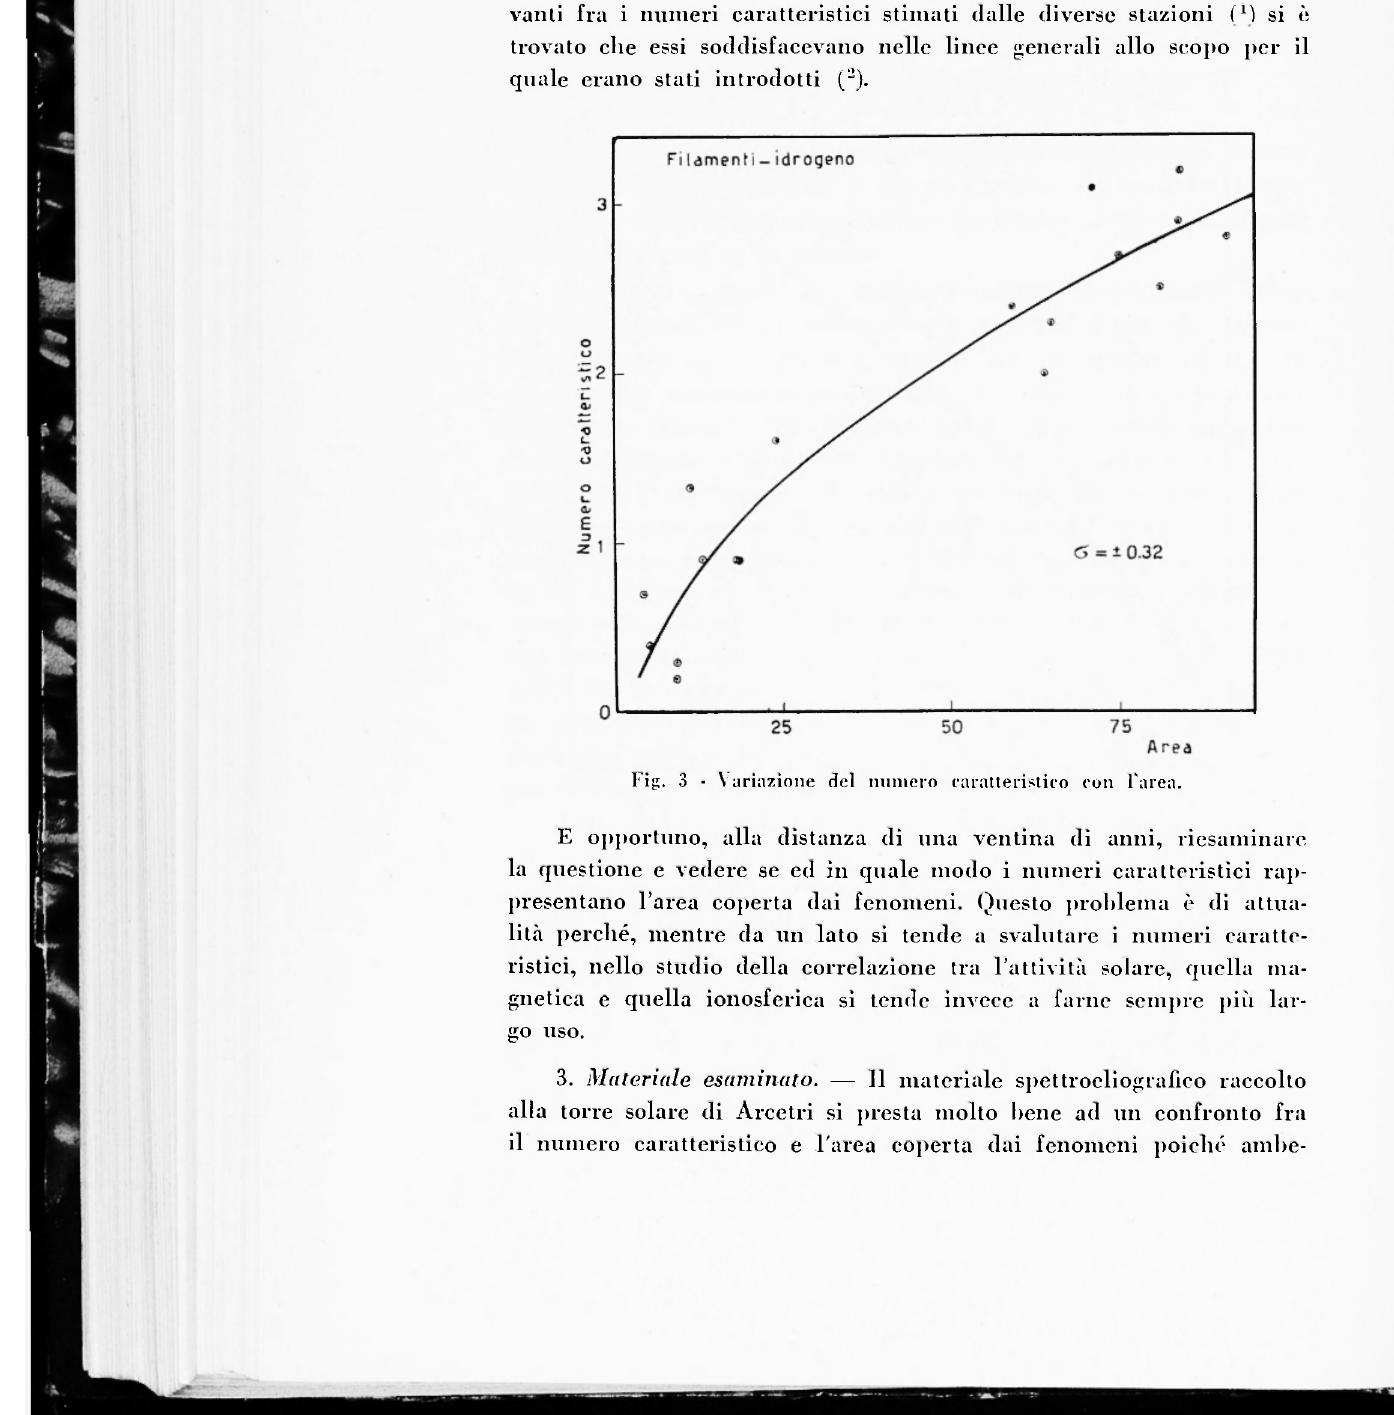
Fig. 3 - \ aria/ione del numero caratteristico con